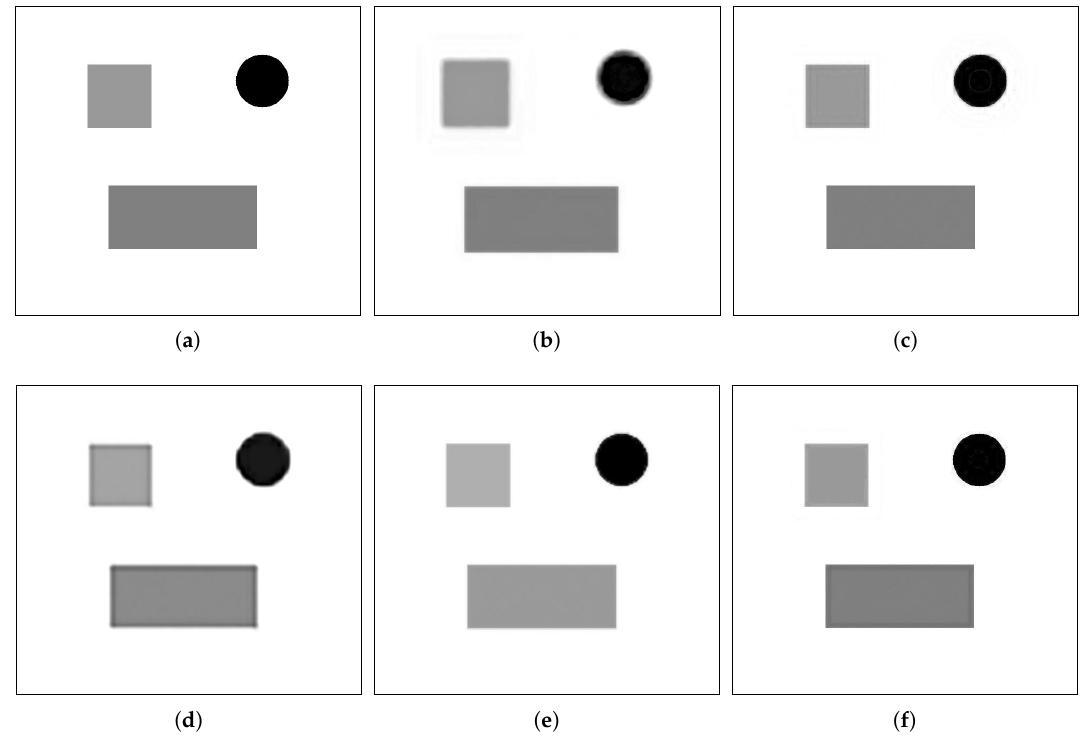
Figure 7. Predicted results of the simulated data: ( a ) the actual Landsat-like image; ( b ) predicted Landsat-like image using STARFM; ( c ) predicted Landsat-like image using SPSTFM; ( d ) predicted Landsat-like image using SRCNN; ( e ) predicted Landsat-like image using FSDAF; ( f ) predicted Landsat-like image using MDBFM. Table 2. Index analysis of simulated